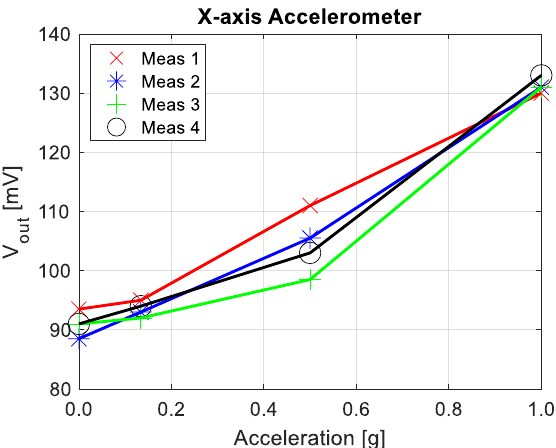
Figure 15. The measured output voltage of the ERC as a function of acceleration. The measured device was positioned at four angles (0, 30, 60 and 90 degrees). The same measurements were repeated four times.